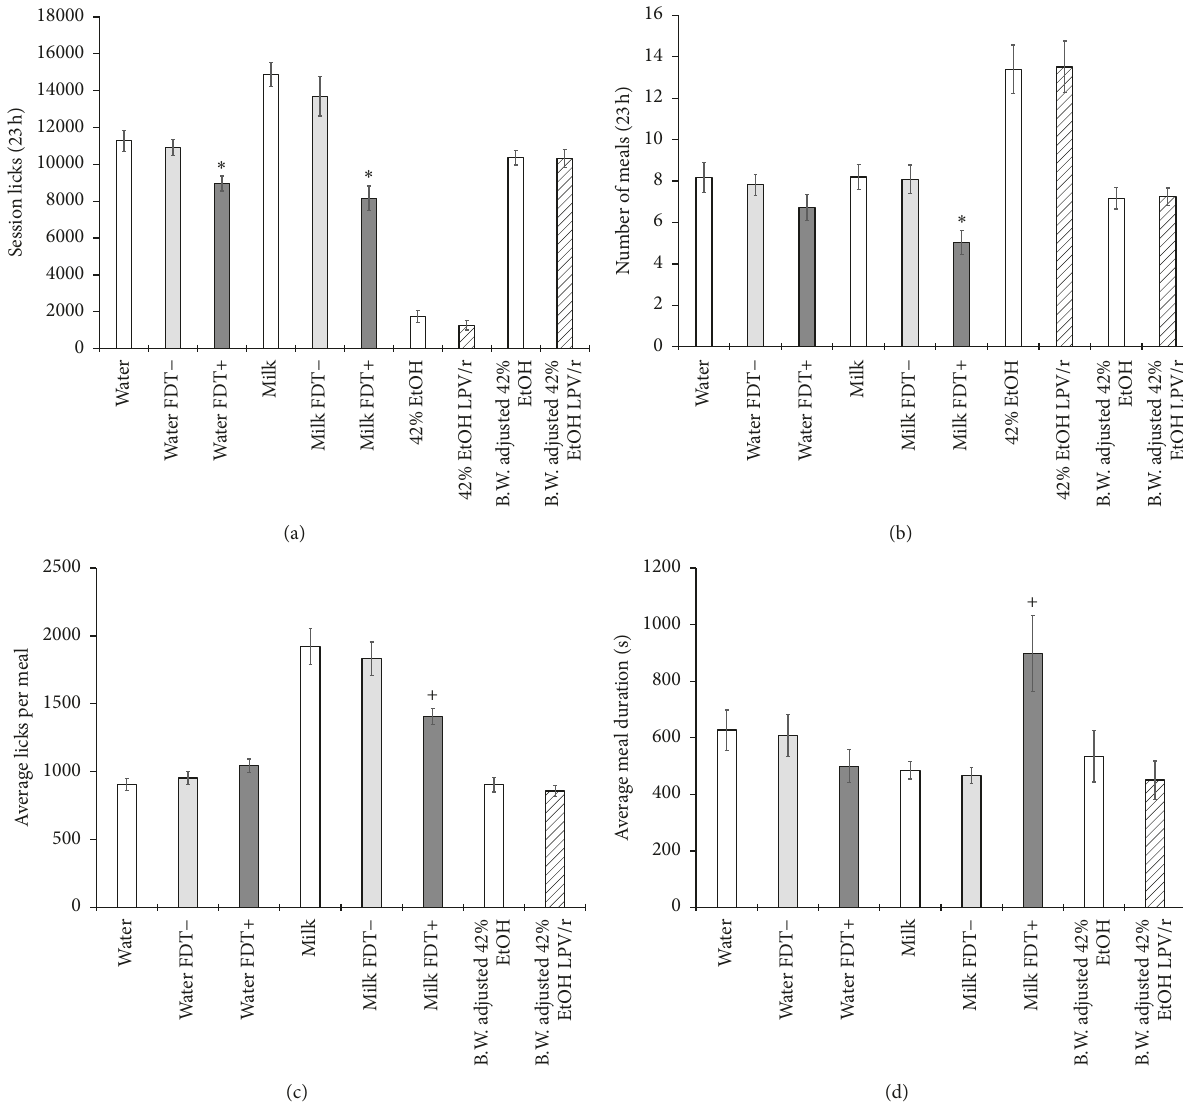
Figure 3: Meal ingestion analysis during 23-h consumption tests with bars representing the means with SEM error bars. Stars represent significant differences ( 𝑝 < .01 ) between solutions containing FDT+ (dark bars) and control solutions (open bars). (a) Total licks to single test solutions. (b) The number of meals defined by pauses greater than 10 minutes. (c) Licks per meal averaged across the test session. (d) Duration of meals averaged across the test